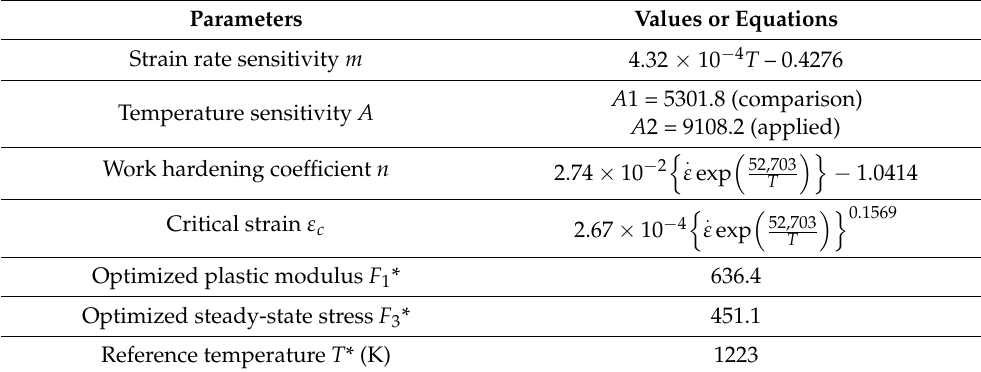
Table 3. Parameters used to obtain the generalized flow curve.